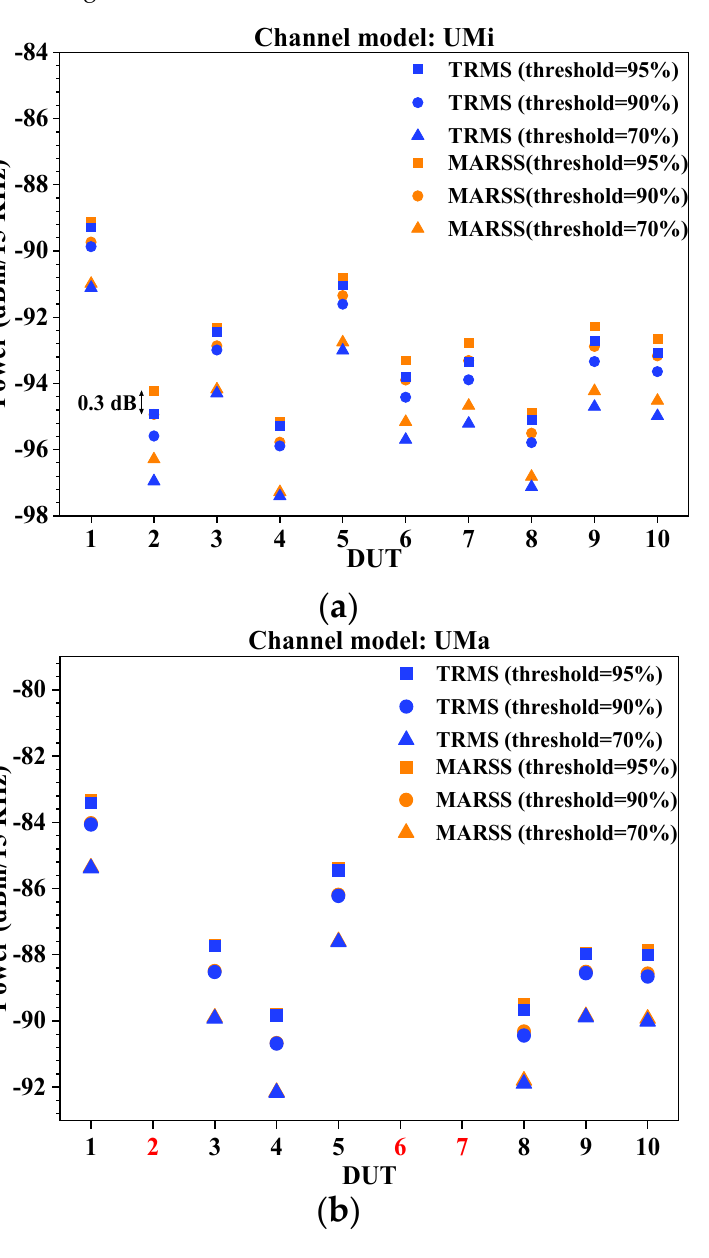
Figure 8. A comparison between the different average manners for ( a ) the UMi and ( b ) the UMa channel models under 3GPP UE noise-limited environmental condition (TRMS raw data).